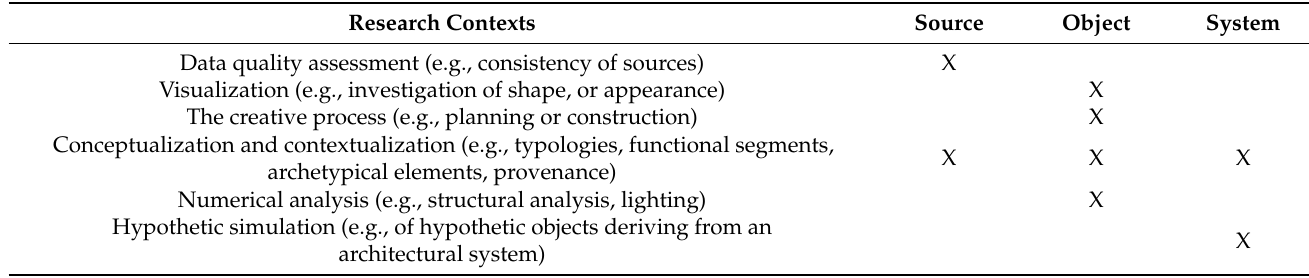
Table 2. Research contexts of digital 3D